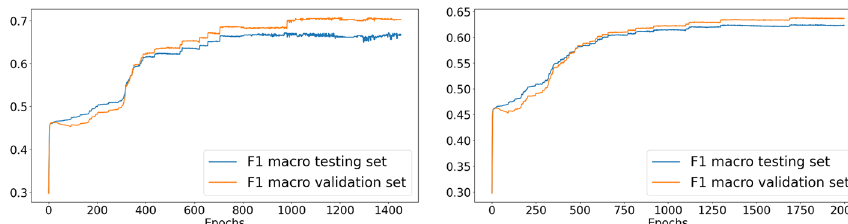
Fig. 10 Testing and validation F1 macro for the final classifier with early-stopping (left) and without early-stopping